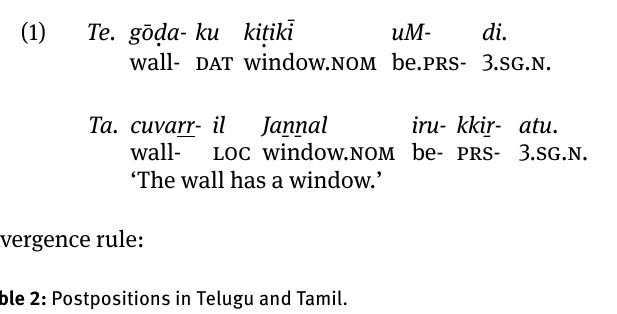
Table 2: Postpositions in Telugu and Tamil. No.